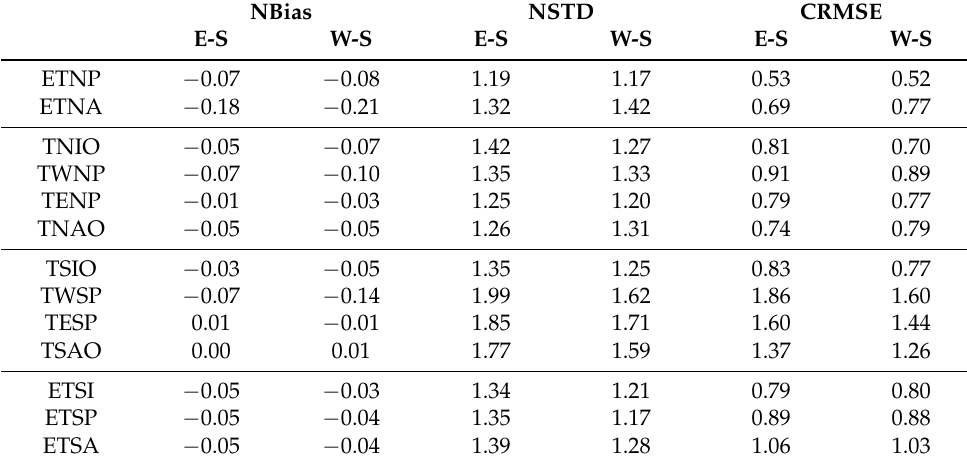
Table 4. Error measures (NBias, NSTD, CRMSE) between (a) (E)RA5 and (S)atellite , (b) (W)W3 and (S)atellite for the 13 subregions (significant wave height)